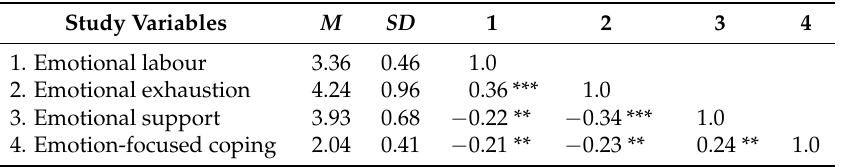
Table 1. Correlations between study